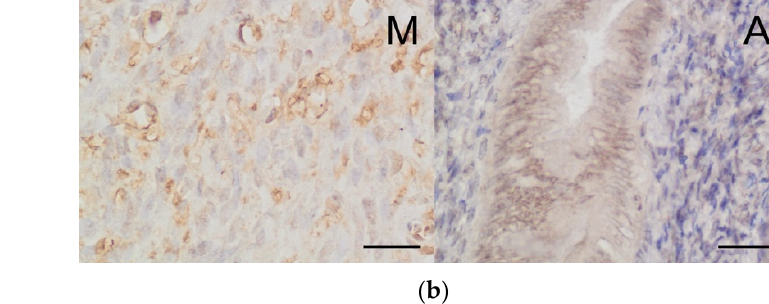
Figure 3. Aromatase expression in adenomyosis and normal myometrium. RT-qPCR analysis of CYP19A1 expression level in myometrium and adenomyosis ( a ). Each column represents the ratio of the expression of investigated gene and ACTB ± SEM. Asterisk indicates significant differences (* p ≤ 0.05). Immunohistochemical localization of aromatase in adenomyosis and normal myometrium ( b ). Original magnification, 40×; scale bar, 50 µm. A, adenomyosis; M, myometrium. 3.3. Adenomyotic Cell Proliferation Is Promoted by Physiological Levels of Estradiol Adenomyotic cell proliferation was significantly increased after stimulation with 10 or 30 nM of estradiol (Figure 4a). Other concentrations of estradiol (1 and 100 nM) did not affect adenomyosis cell proliferation (Figure 4a). Similarly, none the concentrations of progesterone (0.01–1 µ M) had an effect on adenomyotic cell proliferation (Figure 4b).